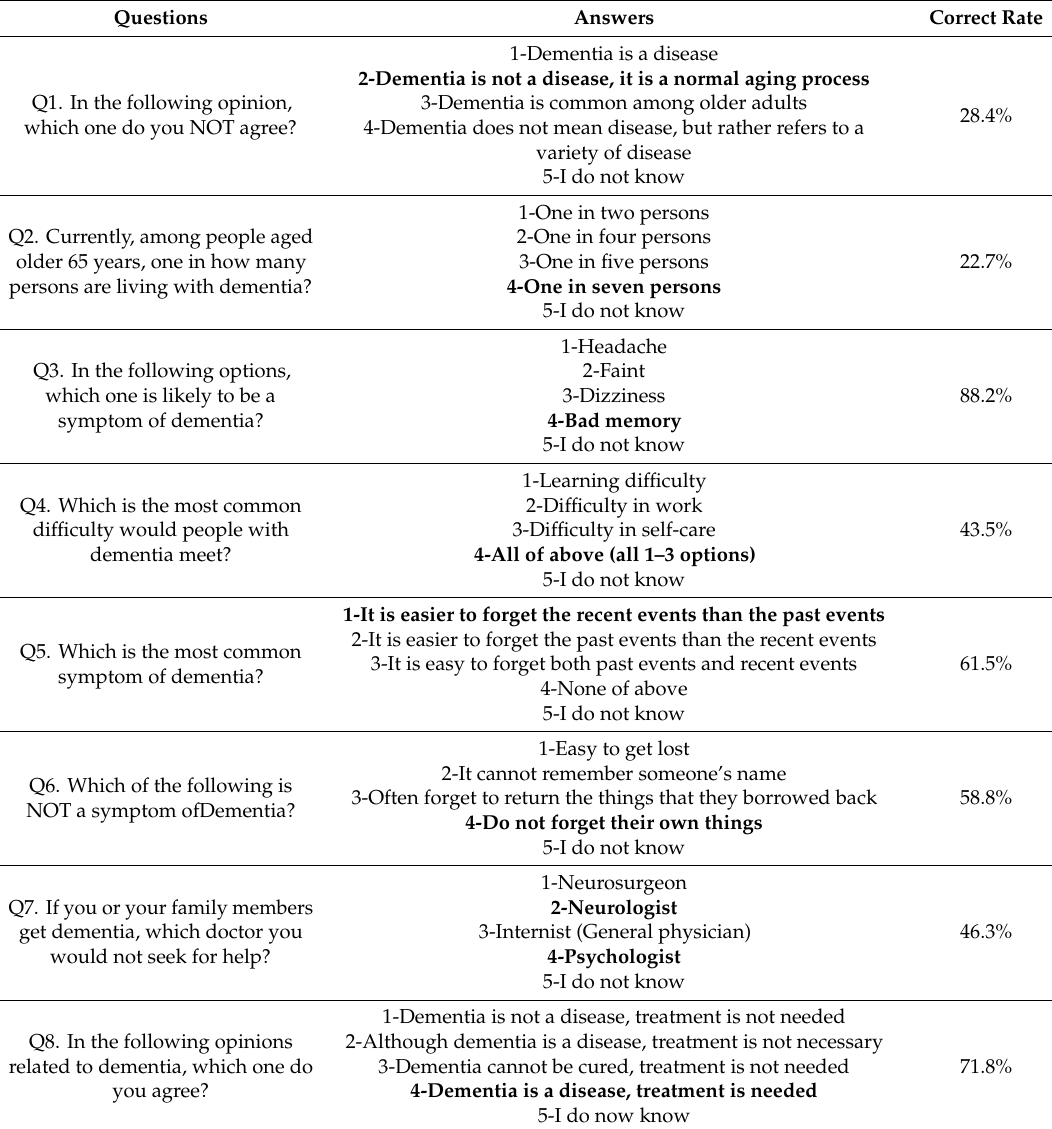
Table 1. Questions of dementia